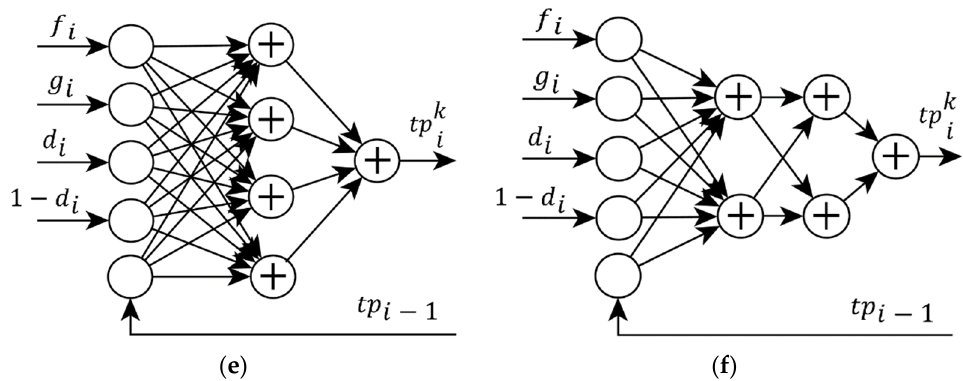
Figure 12. Diagrams of modified neural networks: ( a ) before modification—1 neuron, no hidden layers; ( b ) 1 hidden layer containing 1 neuron; ( c ) 1 hidden layer containing 2 neurons; ( d ) 1 hidden layer containing 3 neurons; ( e ) 1 hidden layer containing 4 neurons; ( f ) 2 hidden layers, each with 2 neurons.